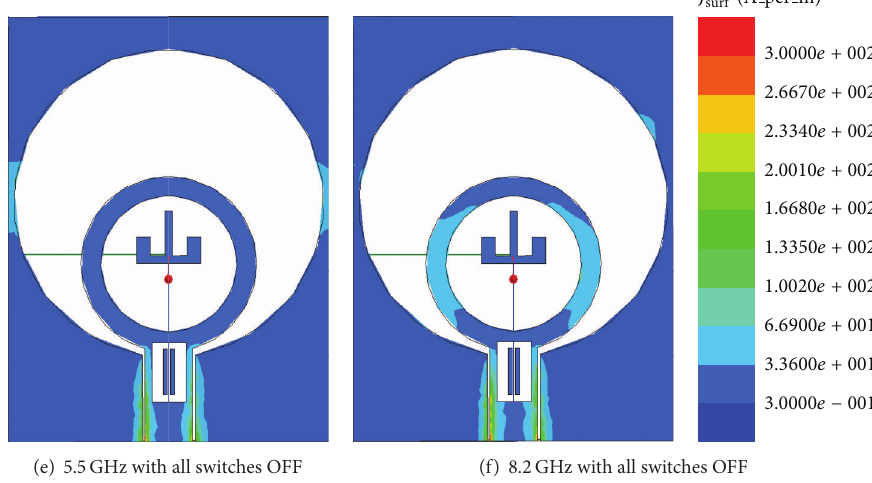
Figure 5: Current density distribution of the proposed reconfigurable dual notch band